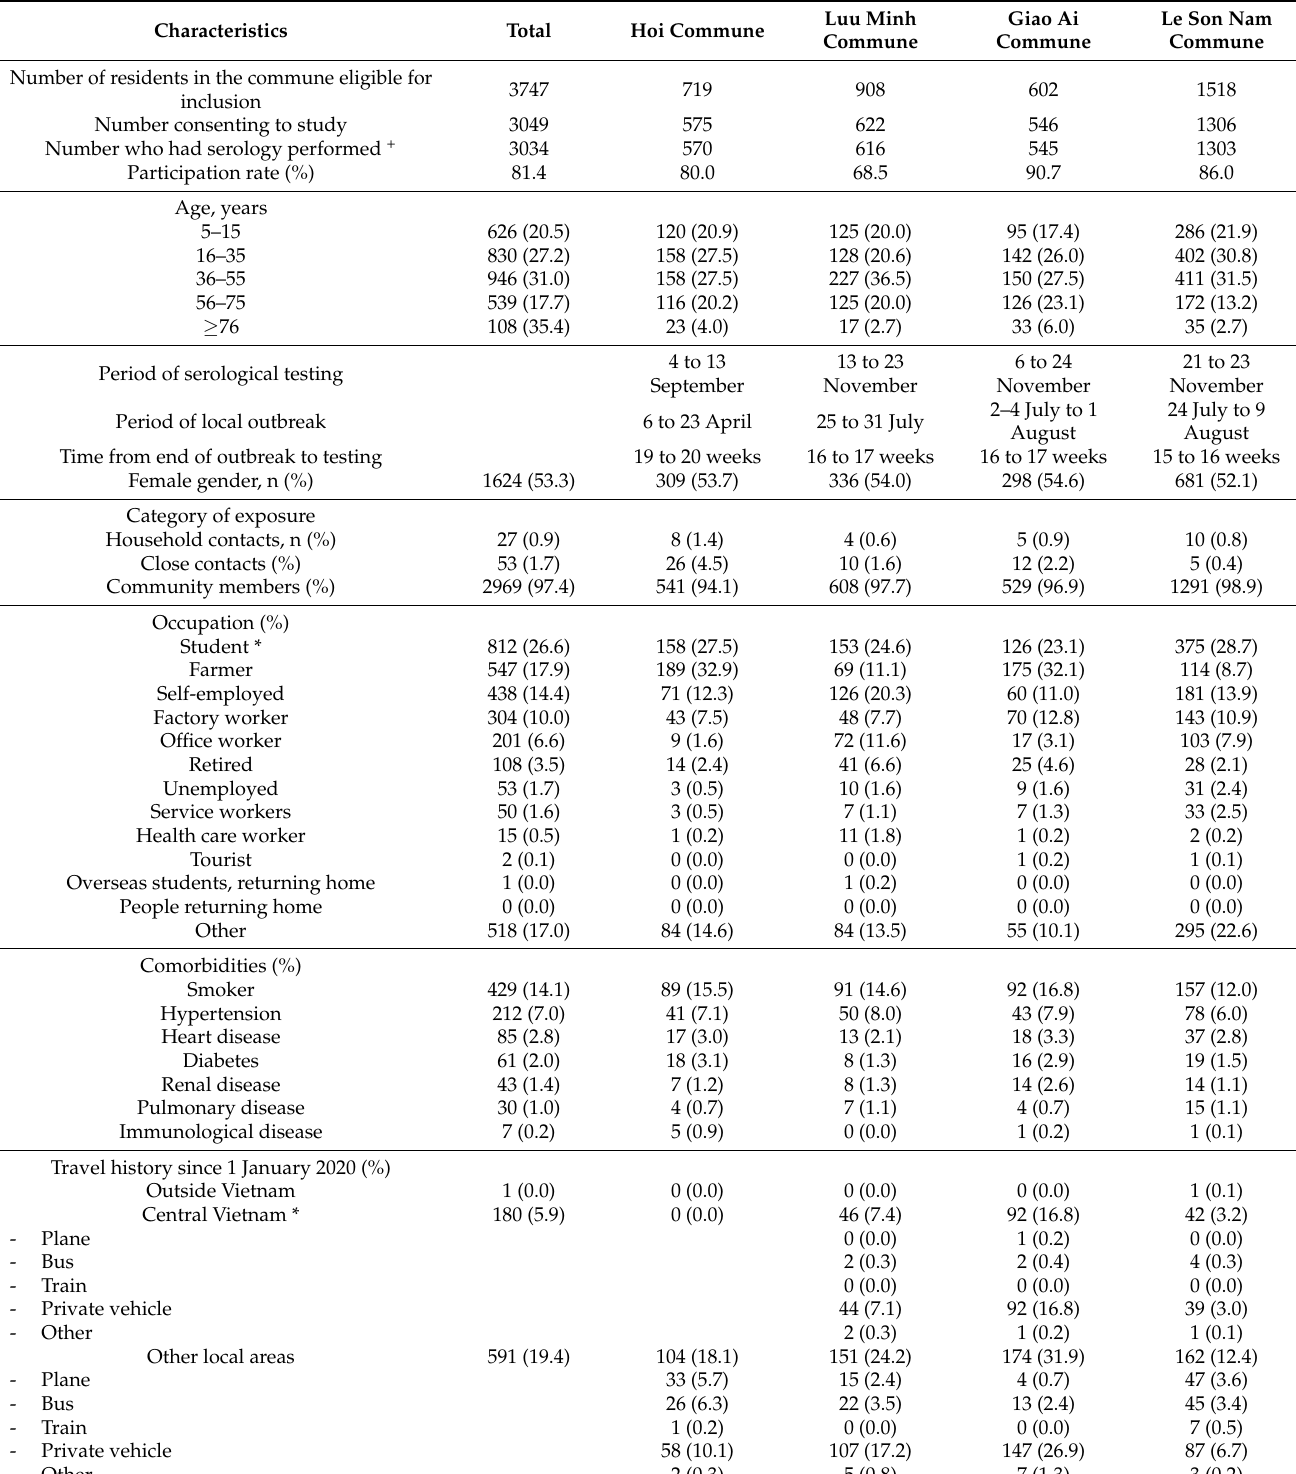
Table 1. Demographic profile and characteristics of all